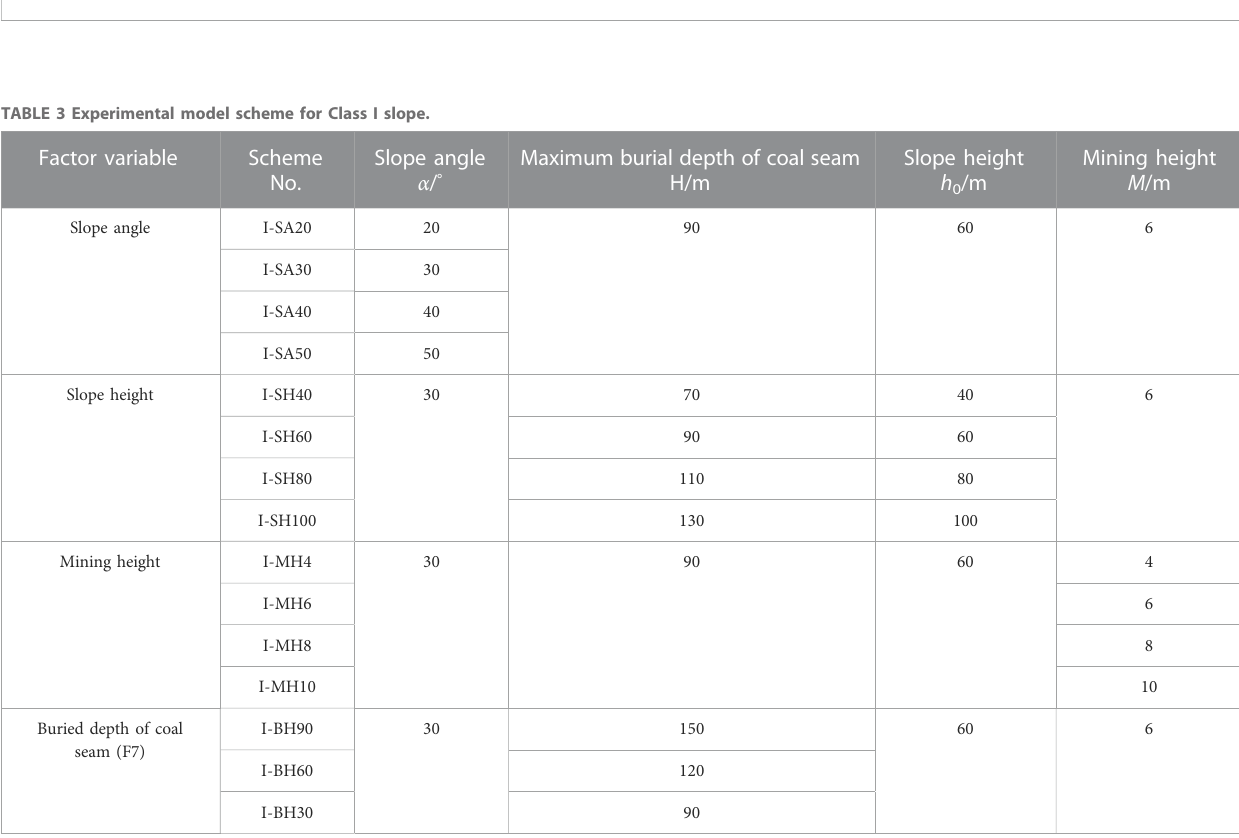
FIGURE 10 Basic numerical model. (A) Type I model (B) Type II model.